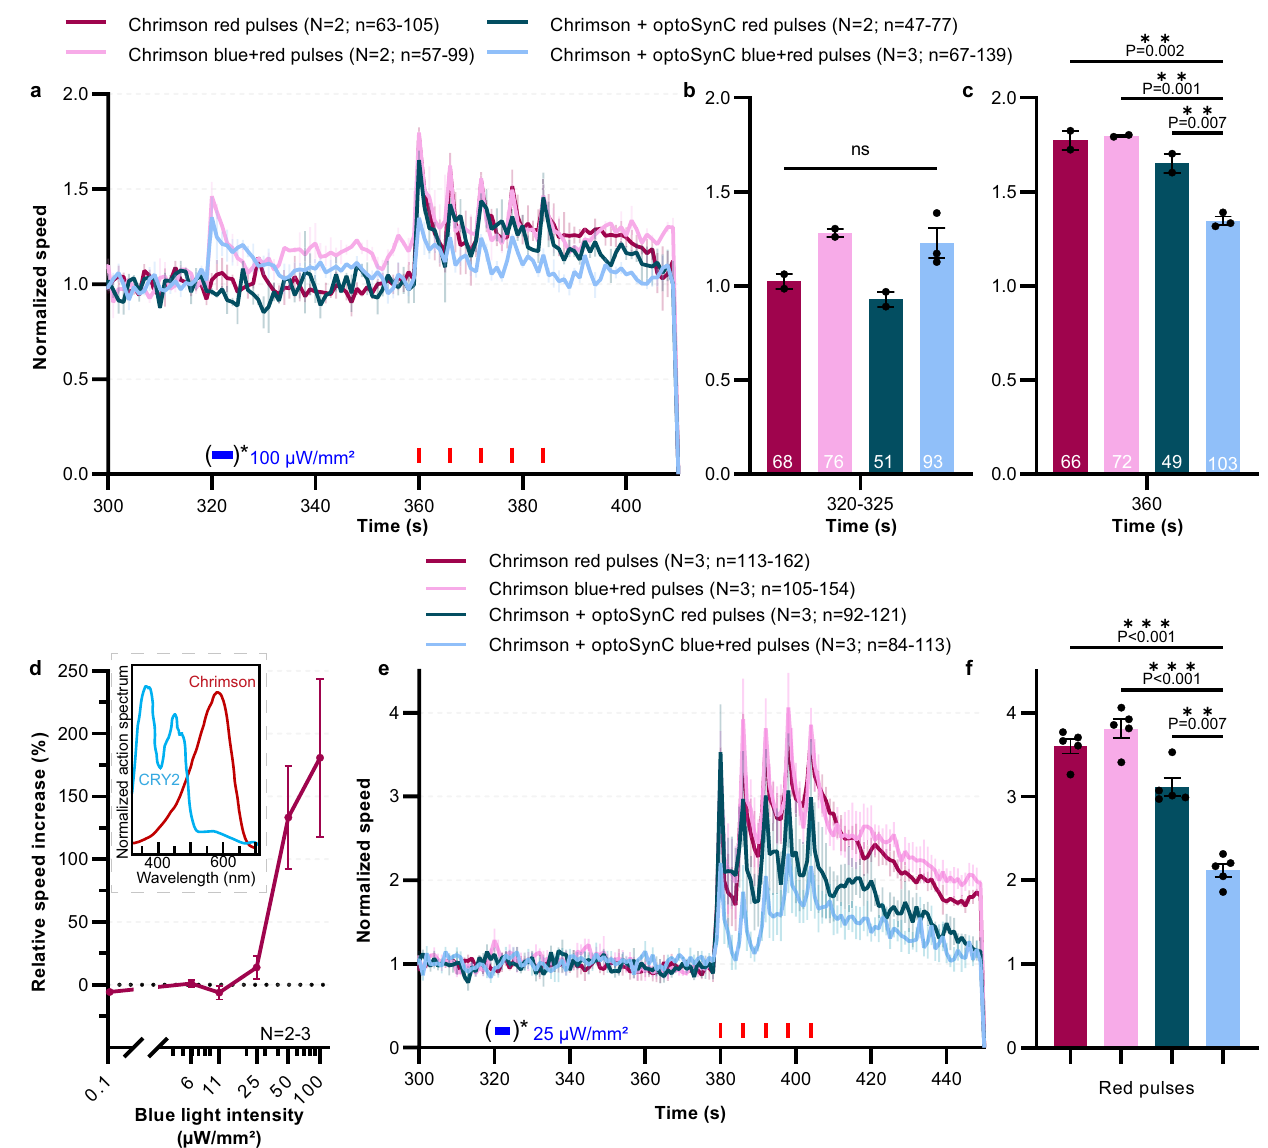
Fig. 8 | Expression of optoSynC in the single nociceptive neuron PVD attenu- ates PVD::Chrimson-evoked velocity increase. a Mean±s.e.m. normalized crawling speed of animalsexpressing Chrimson, or Chrimson and optoSynC inthe PVDneuron.Redlightstimulation(680nm,0.1mW/mm²,1s/5sISI)isindicatedby red rectangles, activation of optoSynC with blue light (470nm, 0.1mW/mm², 5s) by ablue rectangle and asterisk.Dataacquisitionstartedat0s, but animalsareleft to accommodate before starting the experiment. b Group data, mean crawling speed of N =2 – 3 independent experiments (±s.e.m) analyzedduring time intervals with(orwithout)bluepulse(320 – 325s).Numberofindependentanimals( n )across all independent experiments ( N , i.e. animals picked from N independent